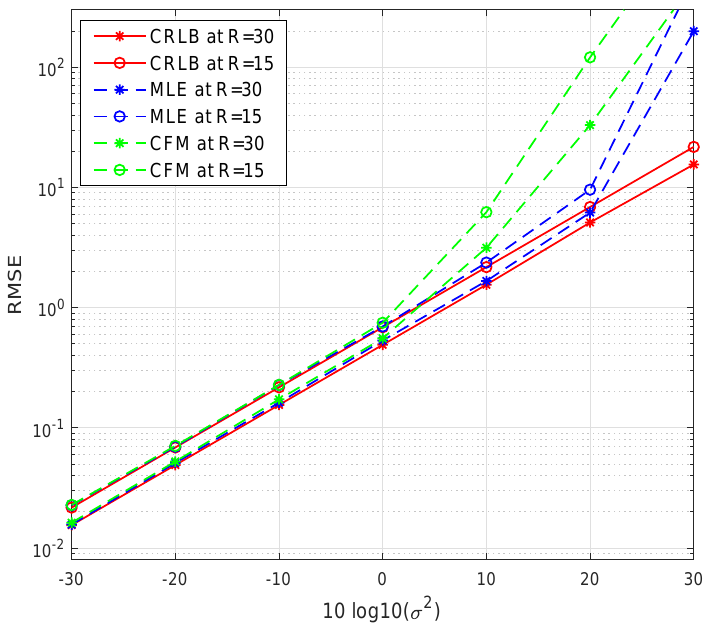
Figure 6. Comparison among CFM, MLE, and CRLB for the second configuration. Based on the power consumption model (2), the required transmitter power for successful telecommunication between two network nodes is directly proportional to the distance between the nodes to the power n ( ∝ d n ), where 5 ≥ n > 2 for obstructed conditions of the system.